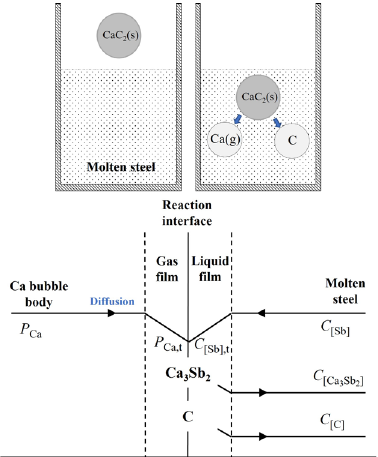
Figure 6. The schematic diagram of the kinetic steps for Sb removal reaction.